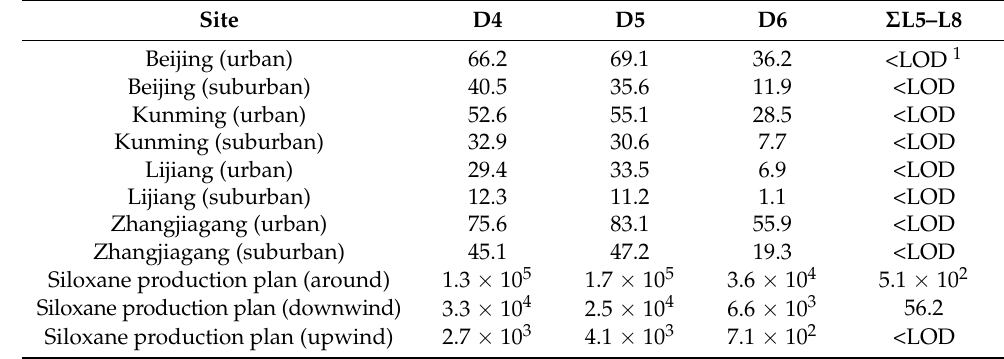
Table 1. The mean concentrations (ng/m 3 ) of methylsiloxanes in air samples from four cities. Site D4